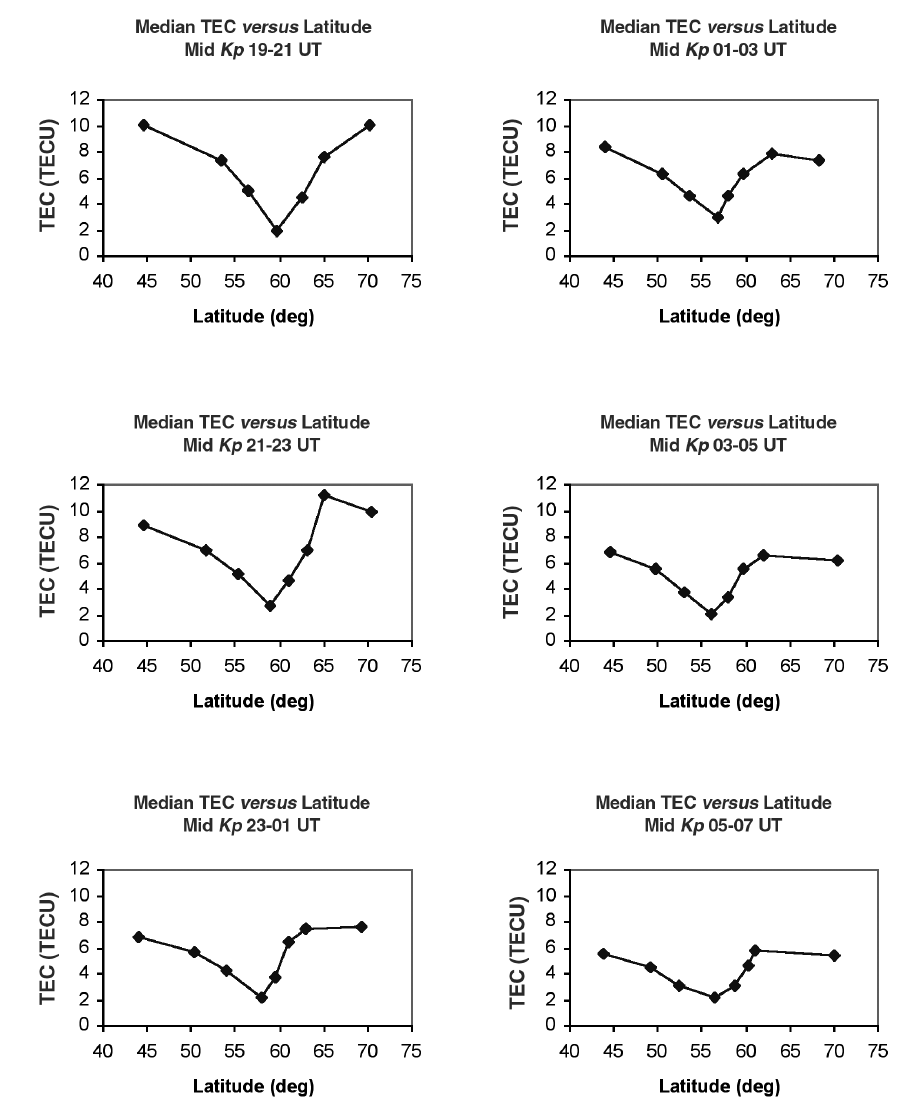
Fig. 8.8b. Median TEC versus latitude profiles of trough shape for successive two-hour bands throughout the night under moderate geomagnetic